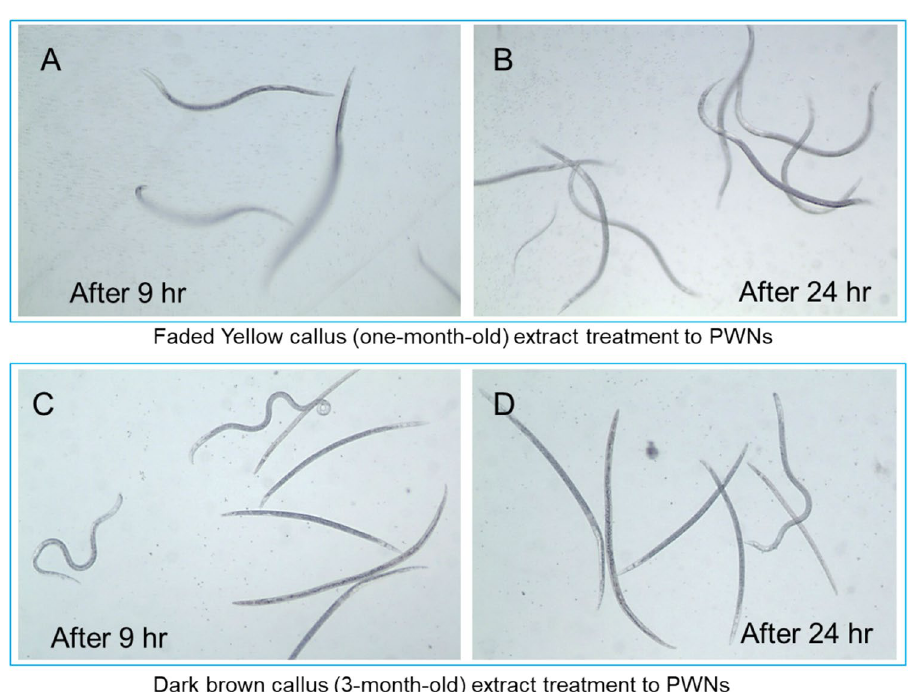
Figure 9. Photographs of PWN mobility after treatment with P. strobus callus extracts. ( a,b ) PWNs with active mobility after 9 h ( a ) and 24 h ( b ) of yellow callus extract treatment. ( c,d ) PWNs mixed with immobilized strait dead body shape after 9 h ( c ) and 24 h ( d ) of dark brown callus extract